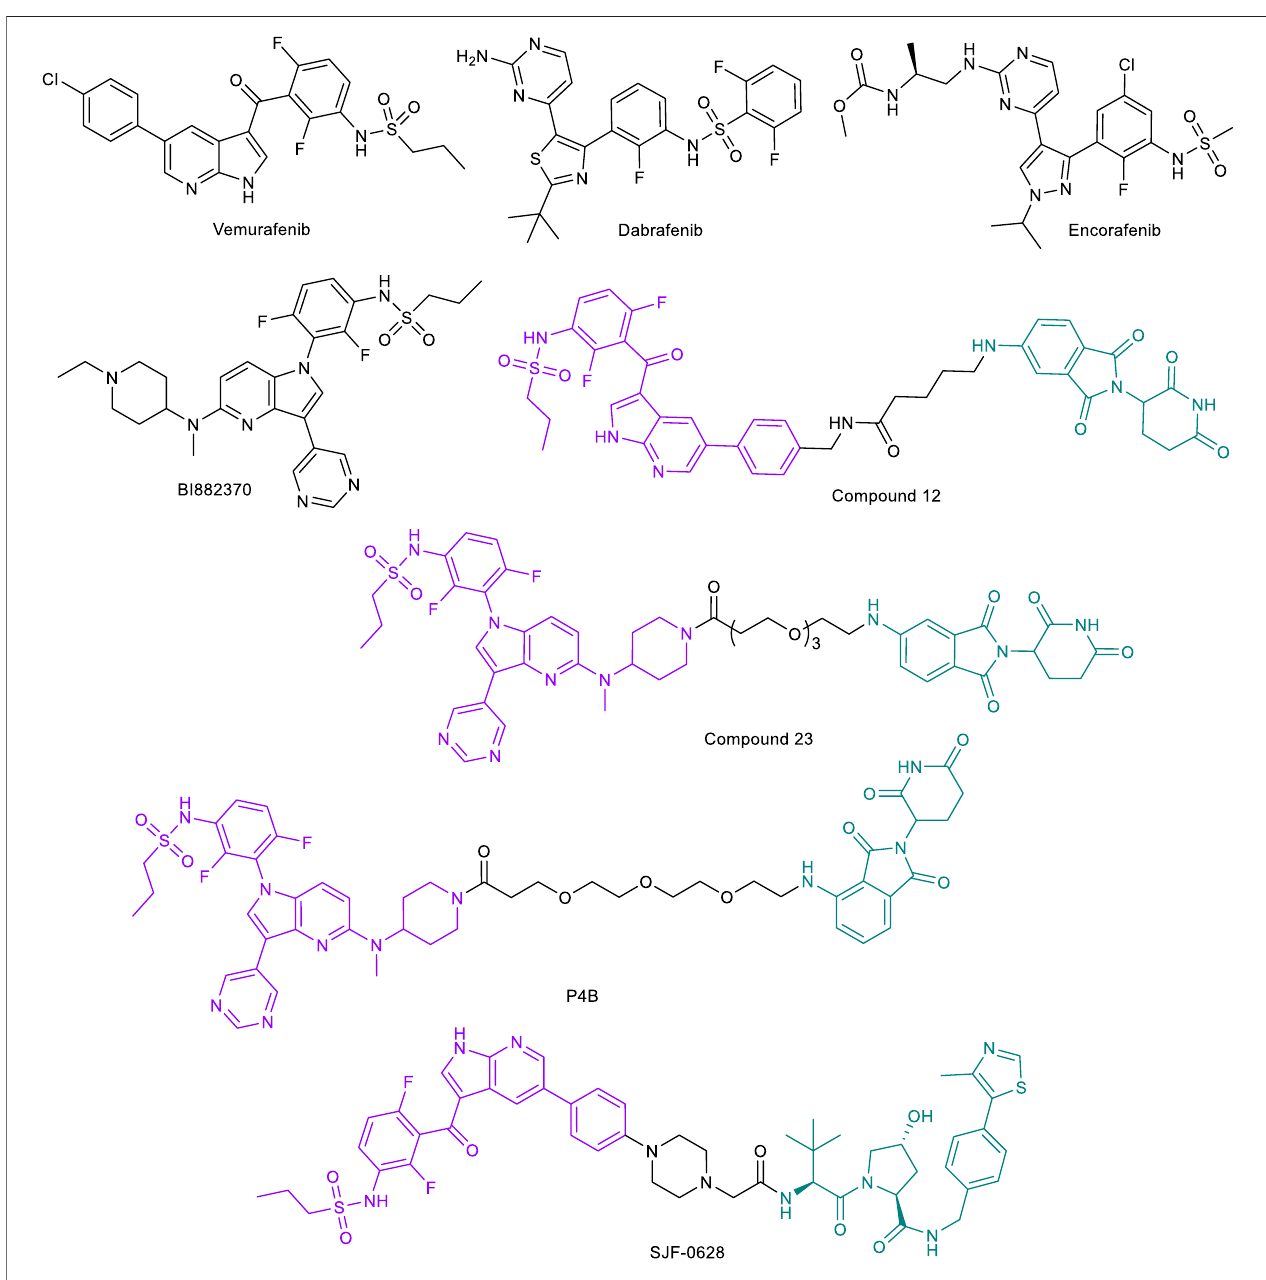
FIGURE 8 | Key BRAF kinase small molecule inhibitors and BRAF-targeted PROTACs.